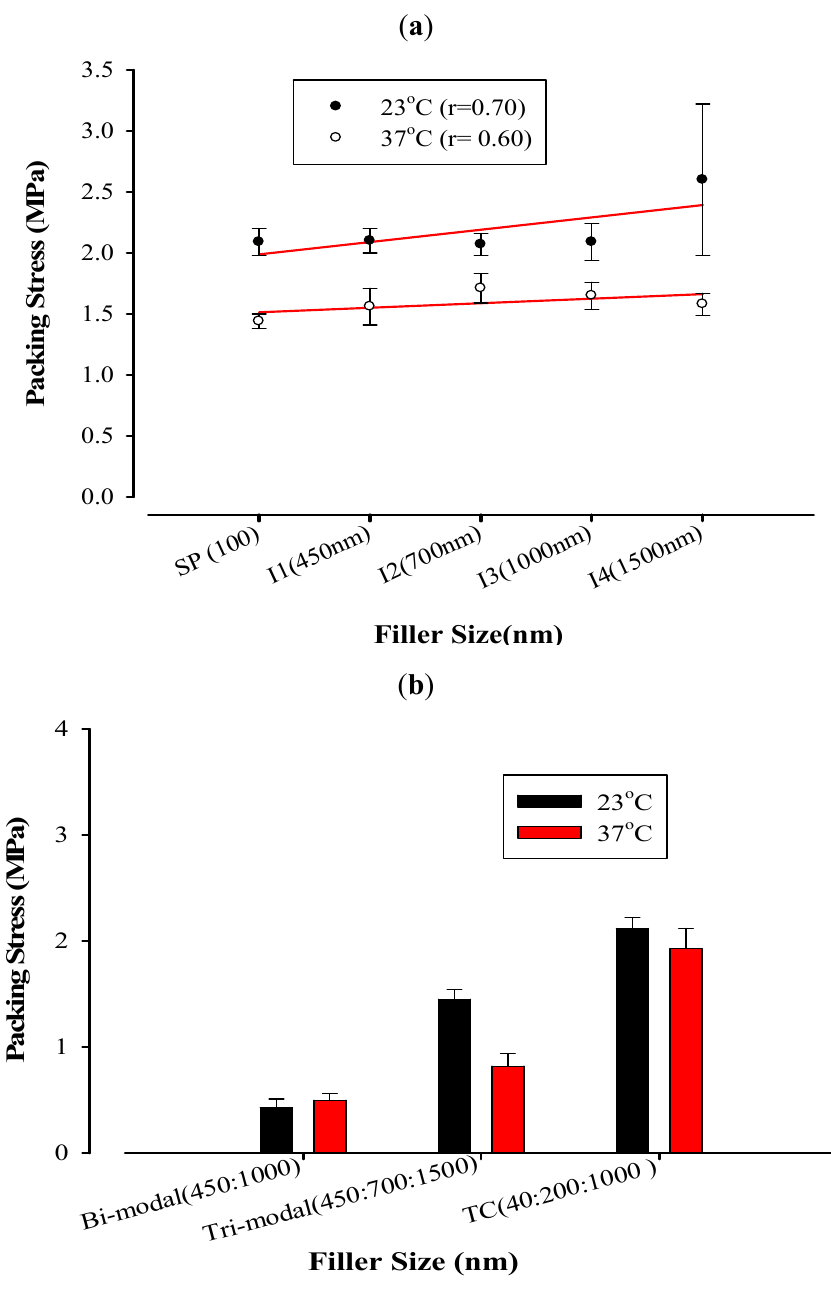
Figure 2. Effect of varying filler sizes at 23 °C and 37 °C on packing stress (MPa): ( a ) Linear correlations between packing stress (MPa) and unimodal composites at 23 °C and 37 °C; and ( b ) Bar Chart of packing stress (MPa) at 23 °C and 37 °C for multimodal